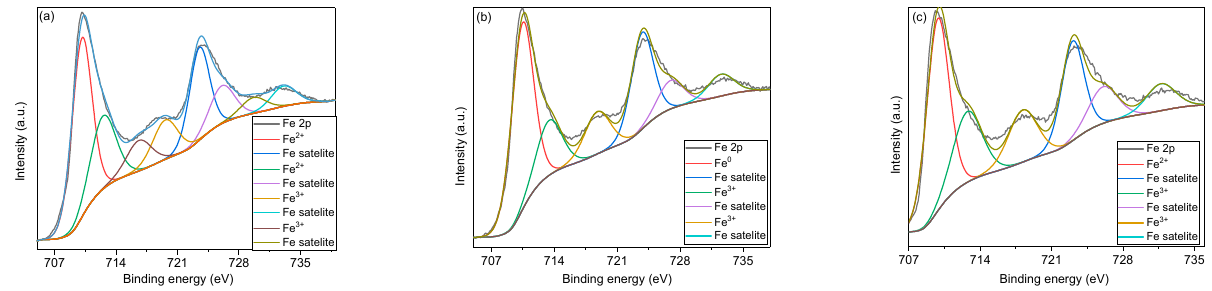
◦ C, ( b ) 800 ◦ C, and ( c ) 1000 ◦